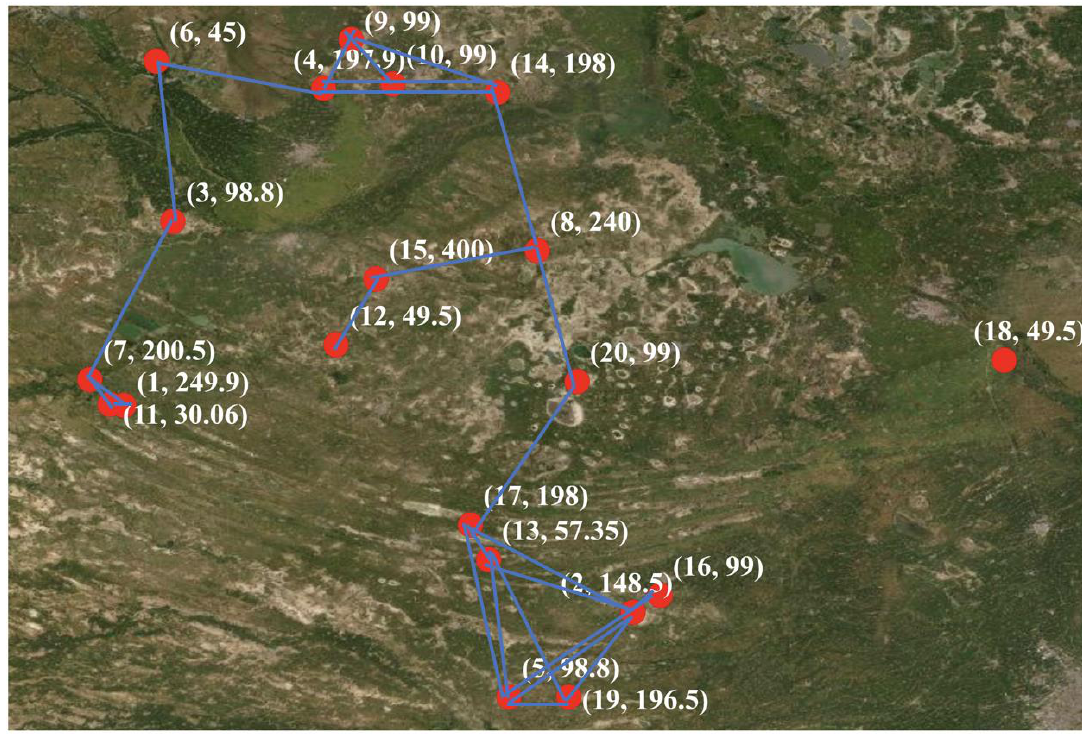
Figure 6. The location of wind farms in the northeast part of